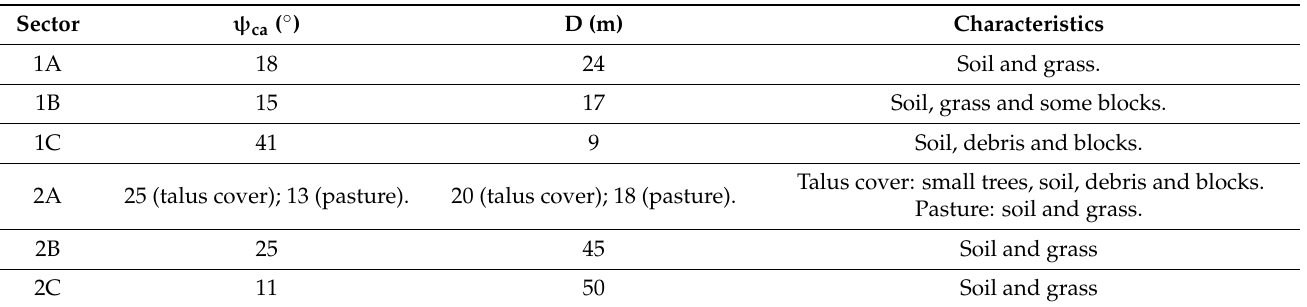
Figure 4. Areas (PR1 and PR2) and sectors of the slope in Cabanas (Google Earth, accessed on 16 December 2016). Table 6. Catchment area features for each sector in Slope ‐ 1.